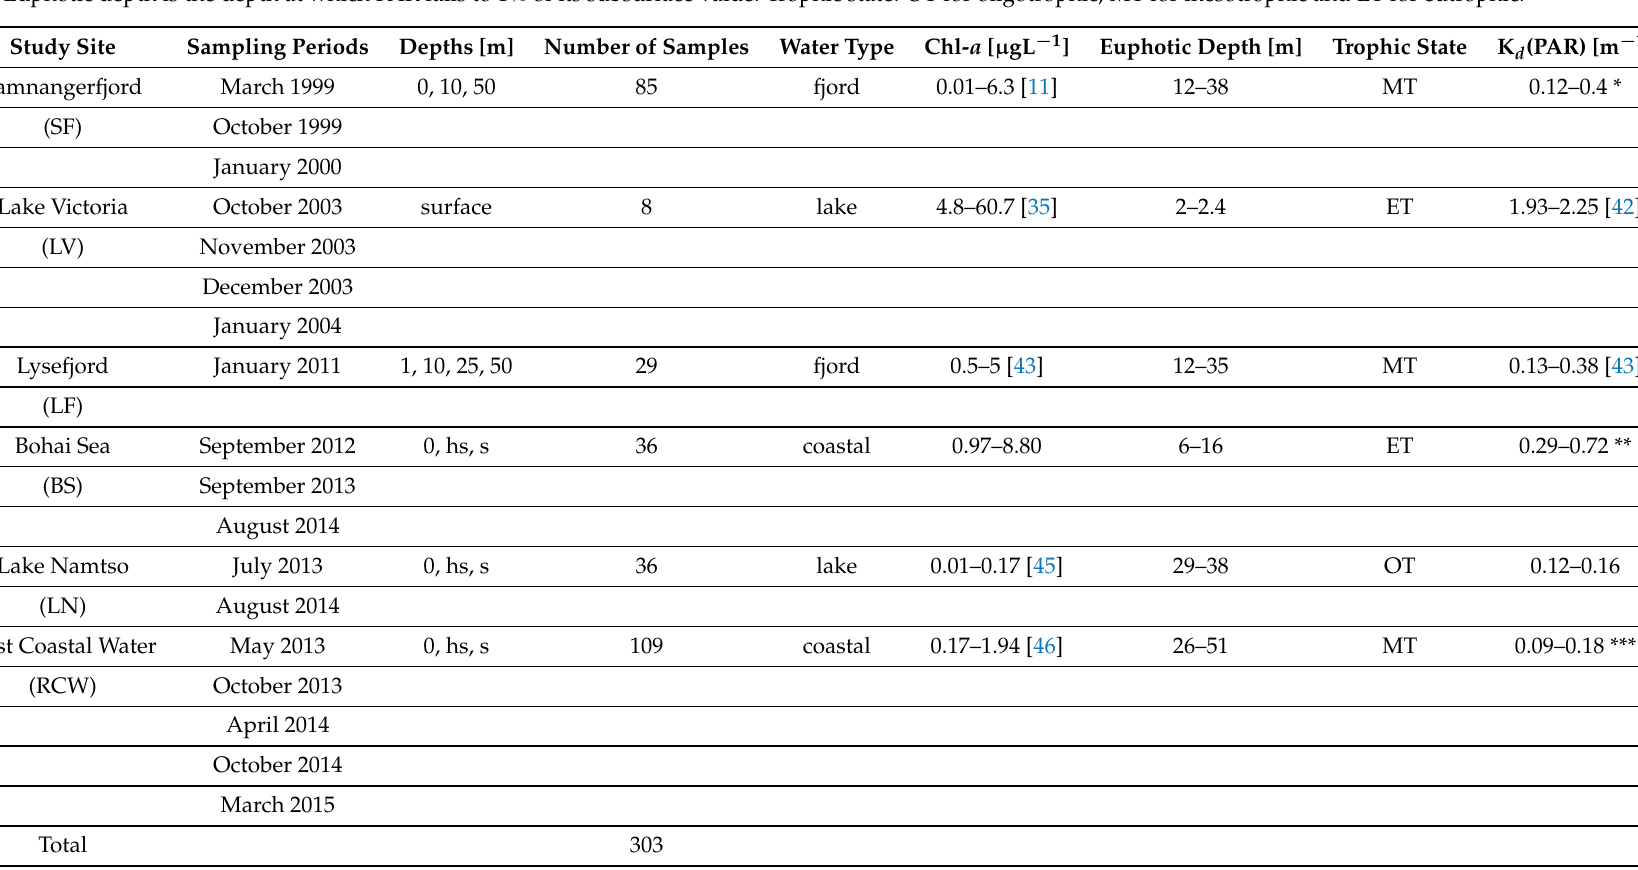
Table 1. For each study site, the columns show sampling periods, depths, number of samples, water type, Chl- a concentration, euphotic depth, trophic state and the vertical diffuse attenuation coefficient for photosynthetically active radiation (PAR). Capitalized letters in parentheses in the first column are abbreviations for the study sites. The symbols ‘0’, ‘hs’, and ‘s’ in the third column refer to measurements at the surface, at half the Secchi depth, and at the full Secchi depth, respectively. Euphotic depth is the depth at which PAR falls to 1% of its subsurface value. Trophic state: OT for oligotrophic, MT for mesotrophic and ET for